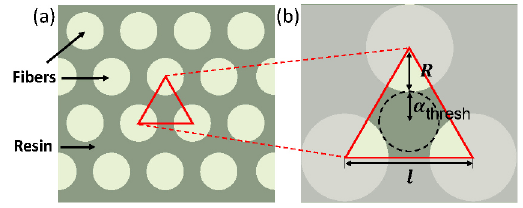
Fig. 19 Geometric relation between the threshold α value α thresh and the radius of the fiber cross-sections R